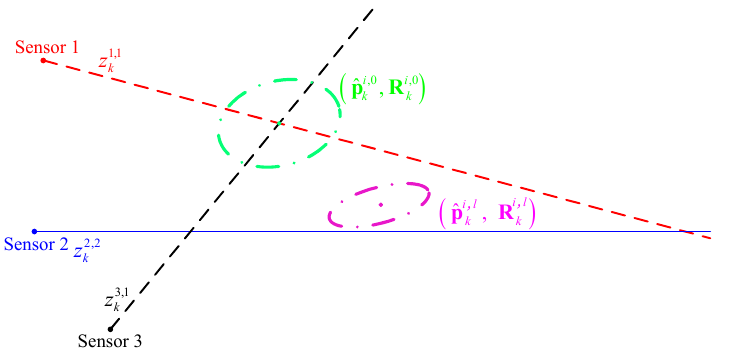
) is the initial , R i ,0 k k